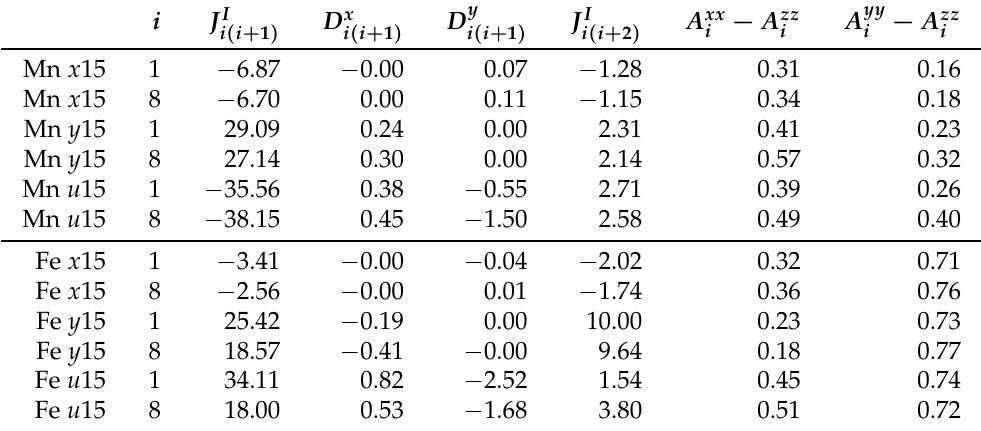
Table 4. Spin model parameters of the 15-atom-long chains in meV units. i = 1 and 8 denote the edge atom (at the end) and center atom (in the middle) of the chains, respectively. For the notation of the spin model parameters see Table 1. Here, the 2NN isotropic exchange interactions, J I also